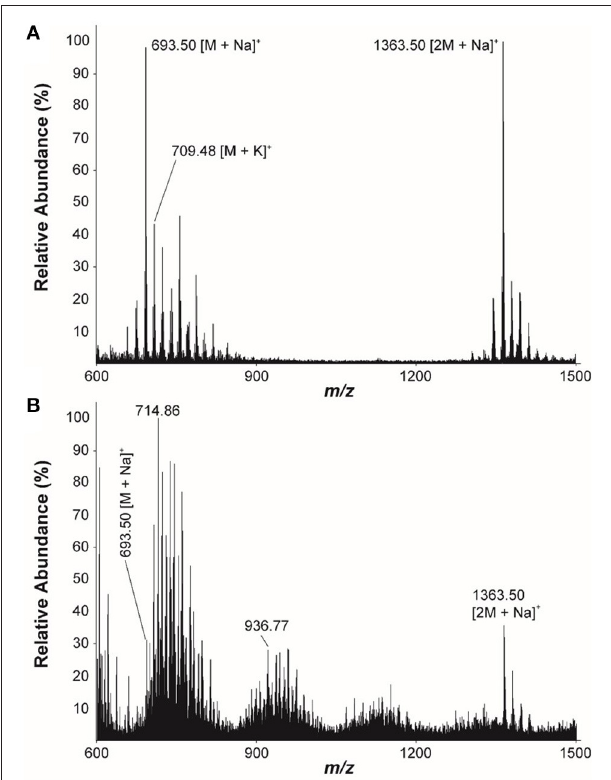
FIGURE 8 | Positive ion-mode MALDI mass spectra of (A) The pure fungichromin and (B) The infructescence specimen (floret part).